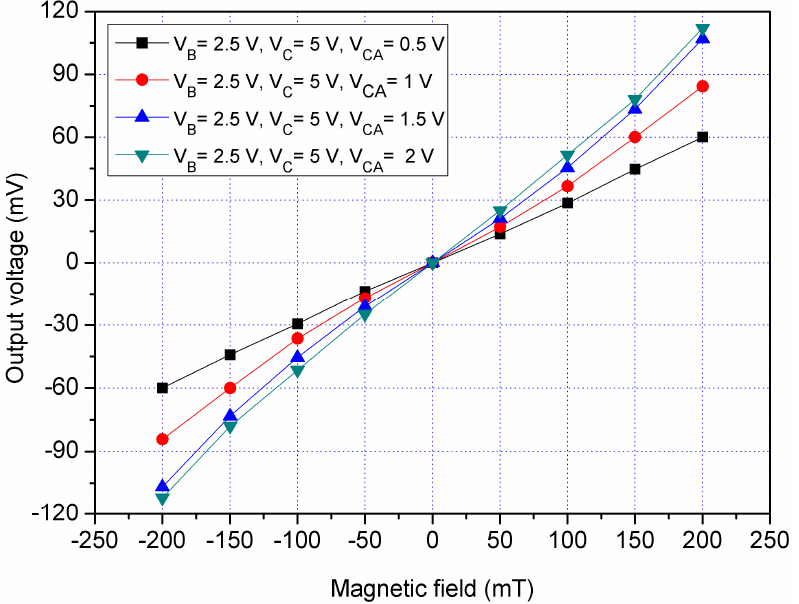
Figure 13. Measured Vo for the x/y-MSE with bias of the additional collectors in the x-direction MF.